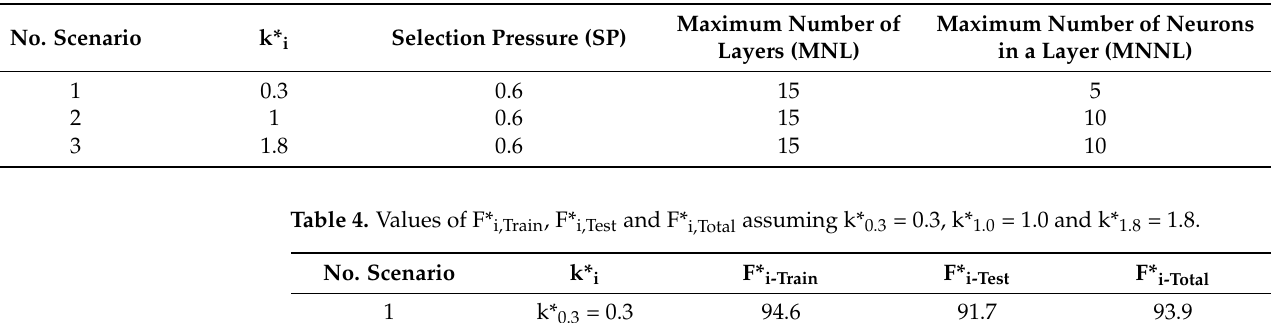
Table 3. Comparison of the three structures of best classification models for three scenarios.